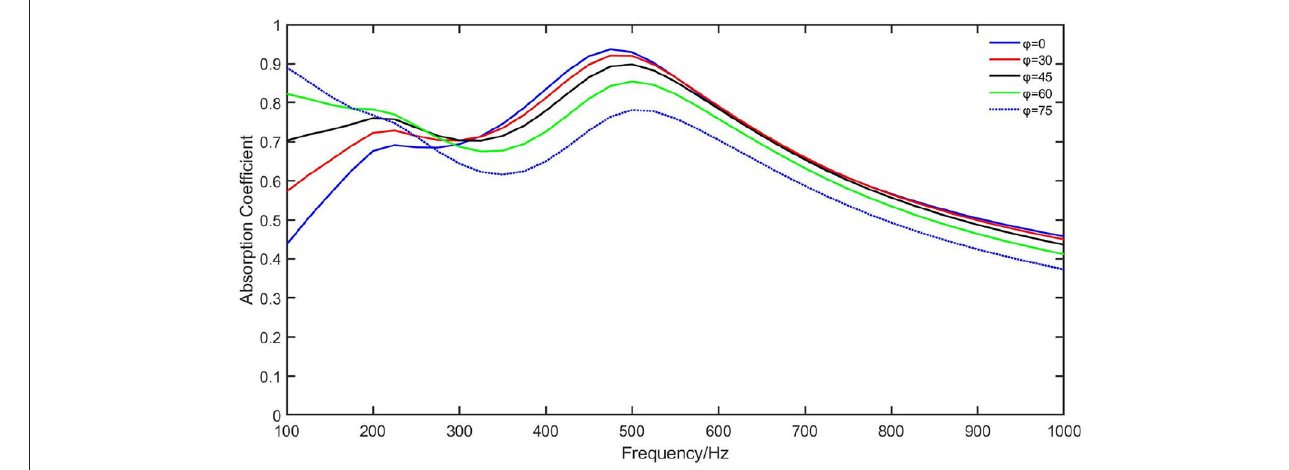
FIGURE 9 | Sound absorption coefficient under oblique incidence.